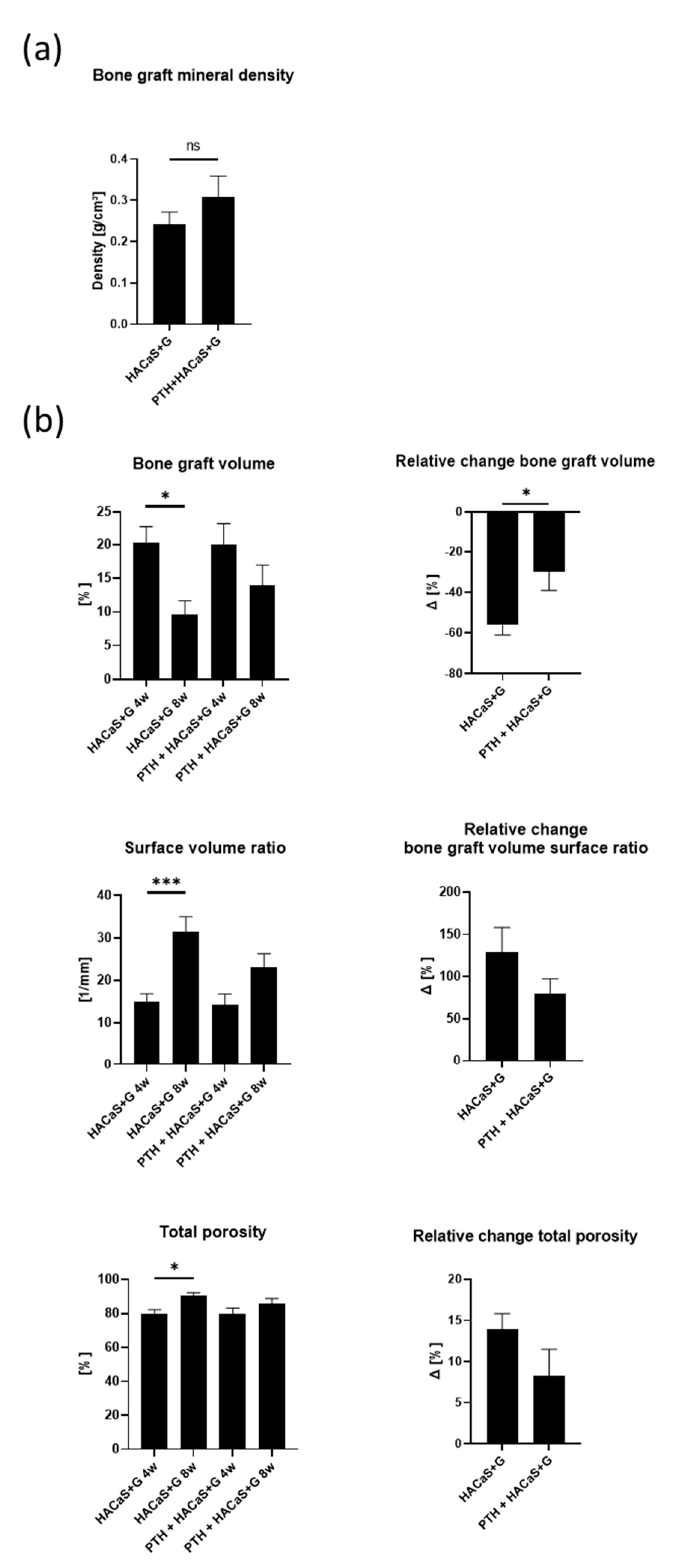
Figure 4. Analysis of bone graft substitute via µ CT: ( a ) comparison of bone graft mineral density 8 weeks after insertion between HACaS+G and PTH+HACaS+G, and ( b ) comparison of 3D analysis of bone graft substitute 4 and 8 weeks after insertion. * = p < 0.05, *** = p < 0.001, ns = not significant .